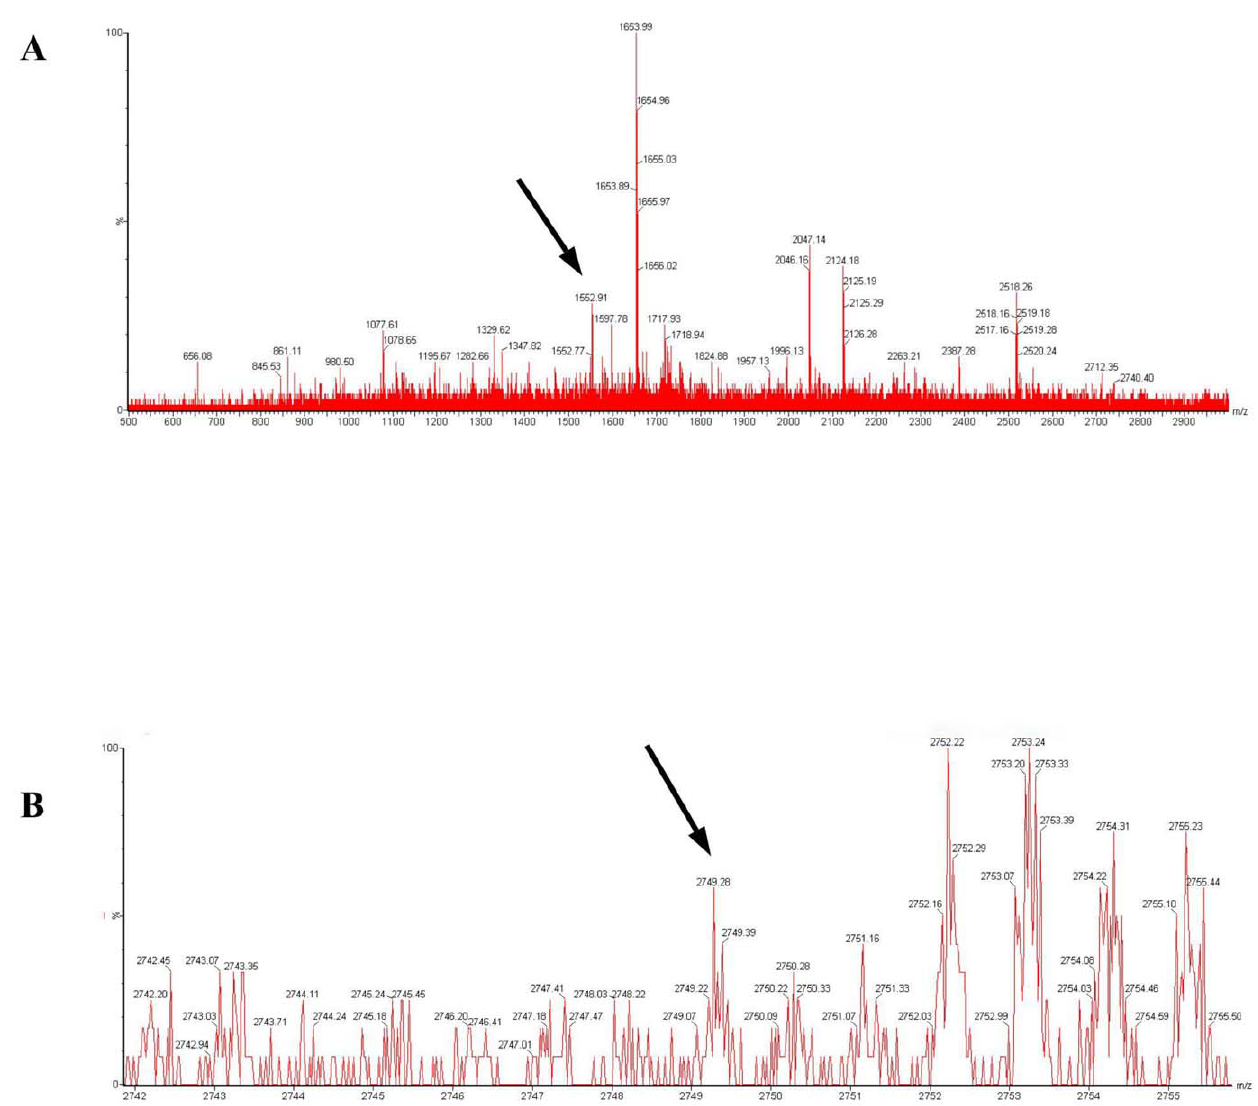
Figure 7. Mass spectra of tryptic peptides of nitrated ERK1. Tryptic peptides of nitrated recombinant ERK1 were immunoprecipitated with anti-nitrotyrosine antibodies. A : Mass spectrum (500–3000 Da) shows a major peak with a monoisotopic mass of 1552.91 corresponding to GLKY 156 - (NO2)IHSANVHR. B : Detailed spectrum (2742–2755.5 Da) shows a major peak with a monoisotopic mass of 2749.28 corresponding to the peptide ASTLEAMRDVYIVQDLMETDLYK containing one nitrated Tyr, Tyr 119 or Tyr 130 . Other peaks correspond to peptides which do not contain Tyr and were adsorbed non-specifically to the anti-nitrotyrosine agarose beads.